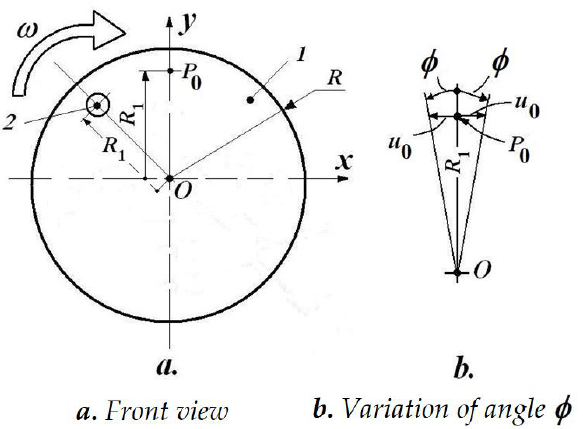
Figure 14. Front view of the flange: 1-the flange itself; 2-one of the fixing bores of the drilling